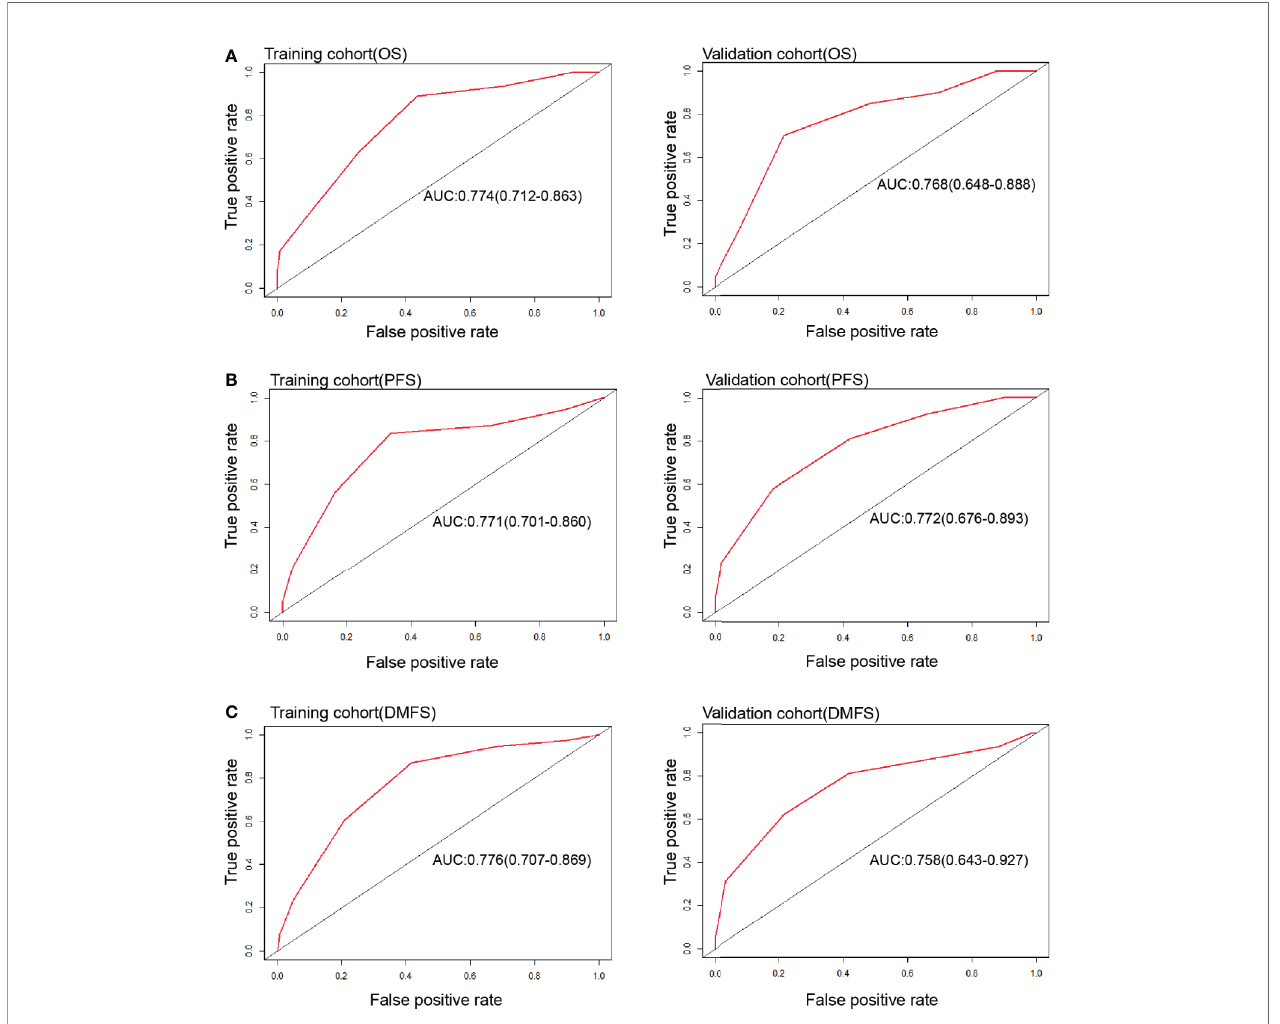
FIGURE 2 | ROC curves of Nomograms to predict 4-year OS (A) , PFS (B) and DMFS (C) in both training and validation